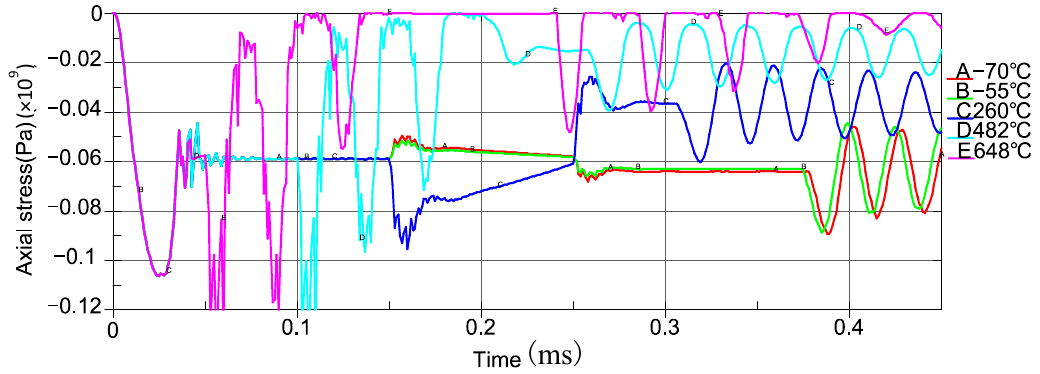
Figure 15. The relation of axial stress with respect to time with different temperatures Table 3. The responses of impact loads under different thermal conditions.